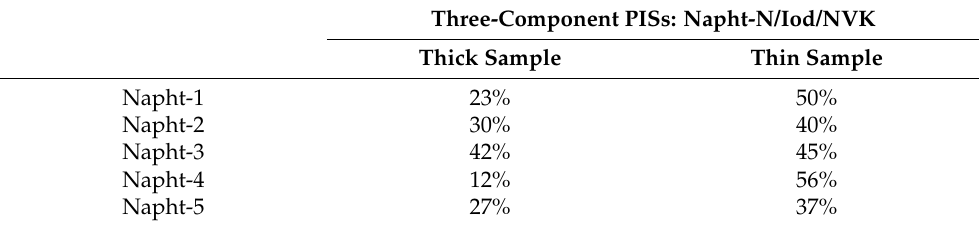
Figure 3. ( A ) Cationic polymerization (CP) profiles of EPOX (epoxy functions conversion vs. irradiation time) upon exposure to the LED@405 nm using three-component PISs Napht/Iod/NVK (0.05%/2%/3% w/w/w ). ( B ) IR spectra recorded before and after polymerization. Irradiation starts at t = 10 s. Table 4. Final reactive function conversions (FC%) for EPOX using three-component PISs upon visible light irradiation using the LED @405